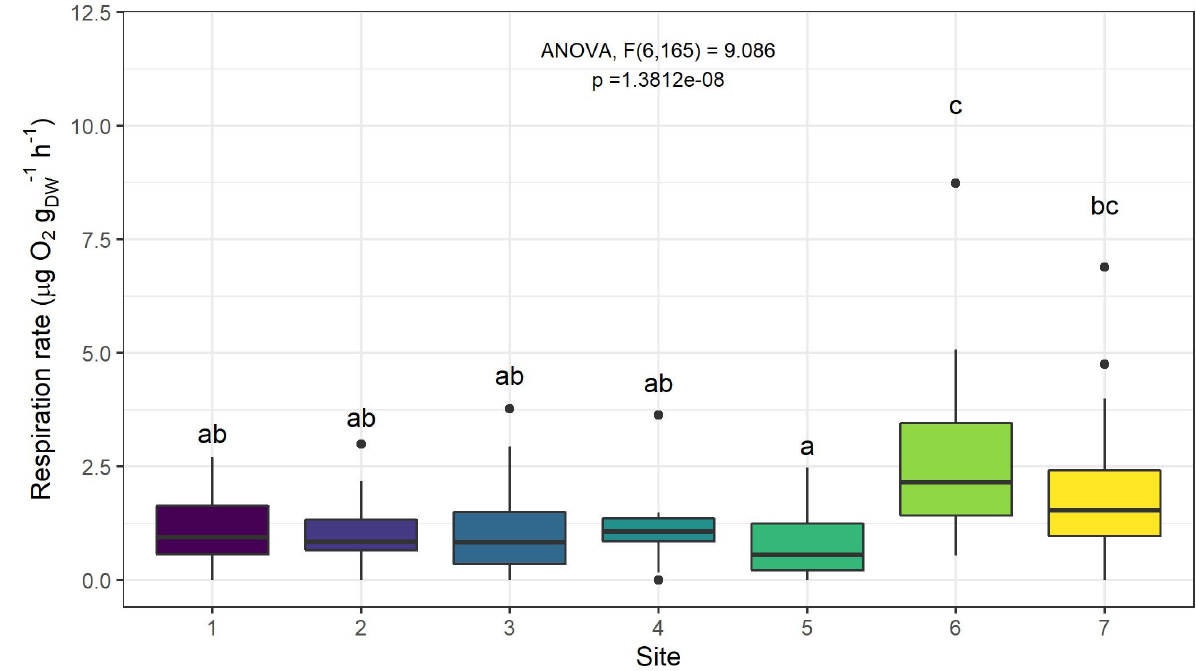
Figure 4. The boxplots represent the variability of the respiration rate across the sampling sites; the hydrological conditions were pooled (n = 25). Hydrological events are pooled for each sampling site. Letters above the boxplot represent the clusters identified in the Tukey ′ s HSD post-hoc test. Different letters (e.g., “a”, “b”, or “c”) identify a significant statistical difference. Strings with two letters identify groups that are not statistically different from the parent groups (e.g., “ab” denotes groups that are not statistically different neither from “a” nor from “b”).